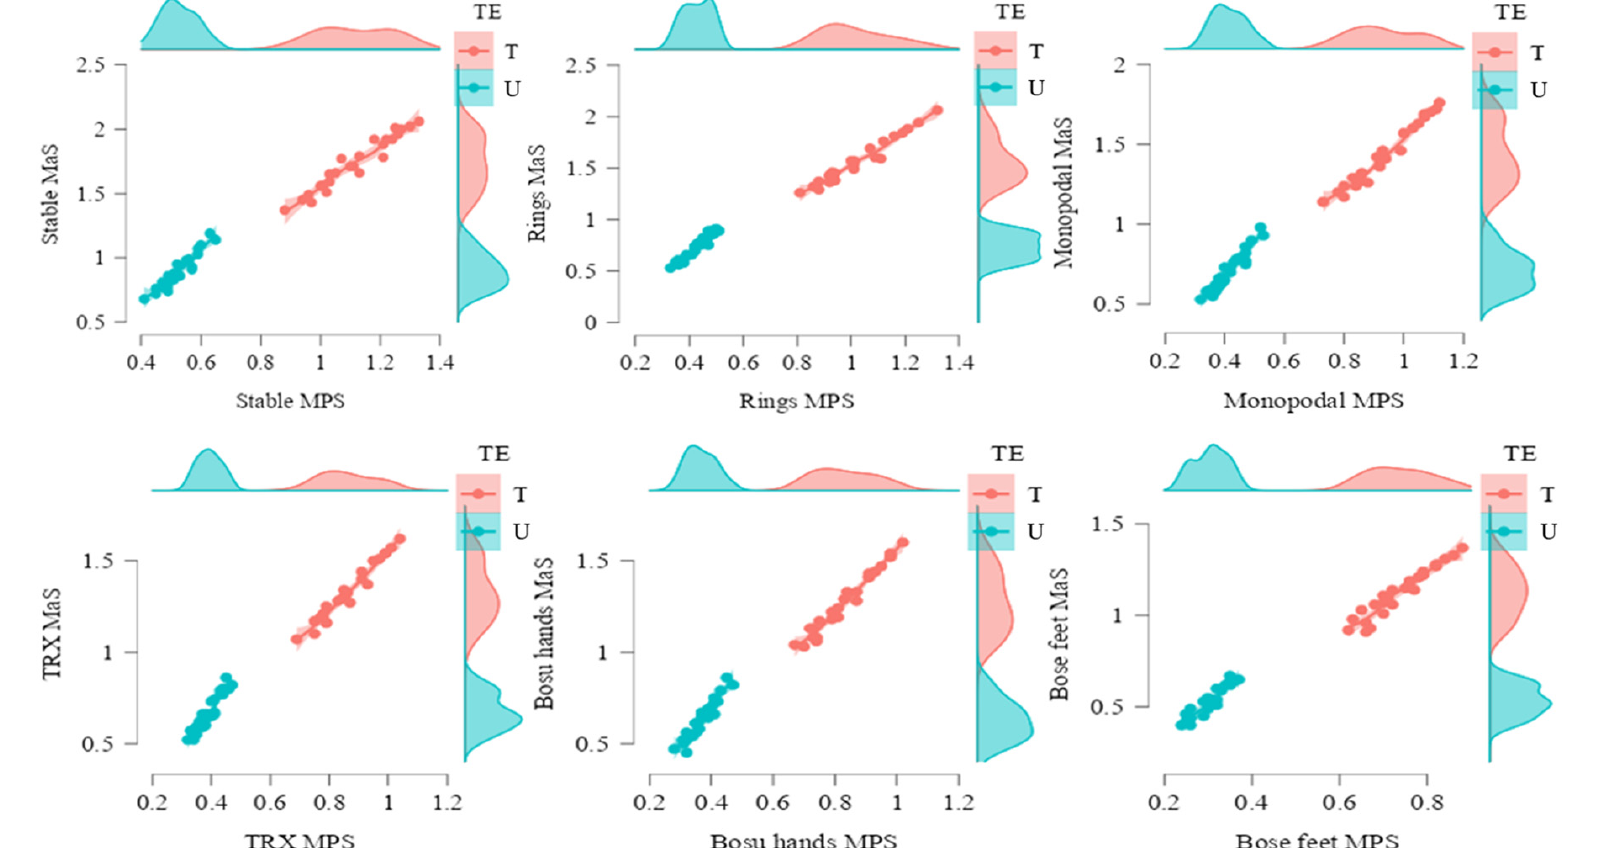
Figure 4. Mean propulsive speed (MPS) and maximum speed (MaS) in the push-up exercise for untrained (U) and trained (T) groups based on experience (TE) for unstable performance tasks, measured in meters/second (m/s). Notes: The figure shows the two variables analyzed in each execution. On the X axis the values of mean propulsive speed and on the Y axis the values of maximum speed. The colors show the different groups, trained in pink and untrained in blue. The dots represent the values of the subjects and the dispersion. A line representing the trend has also been added and the colored areas are the confidence intervals. On both axes the density of the points according to the categorization of the subjects is also